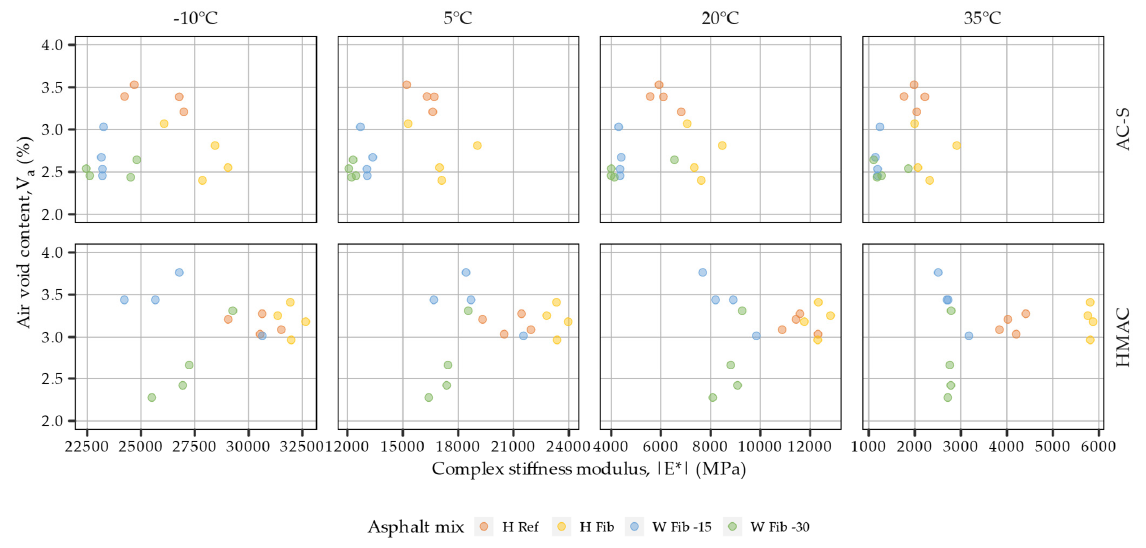
Figure 6. Complex stiffness moduli measured at 10 Hz versus air void content in laboratory produced samples from surface course and high modulus asphalt